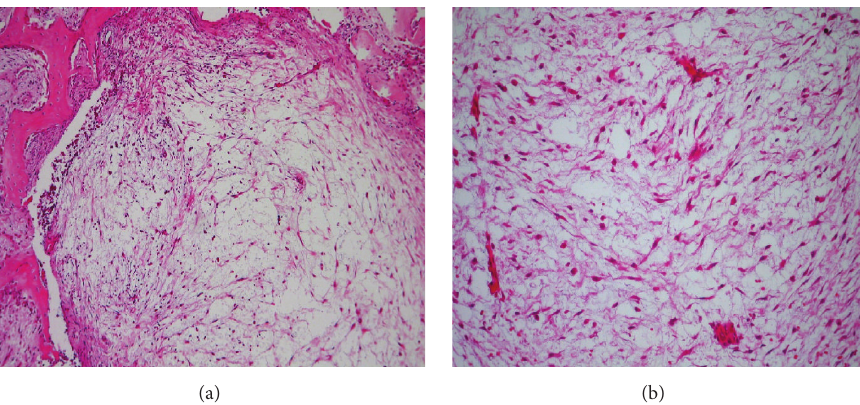
Figure 4: Odontogenic myxoma: (a) H&E × 10: a lobular and loose myxomatous tumor surrounded by alveolar bone. (b) H&E × 20: note the spindle and stellate cells in a myxoid stroma with few collagen fibrils and delicate capillary vasculature.